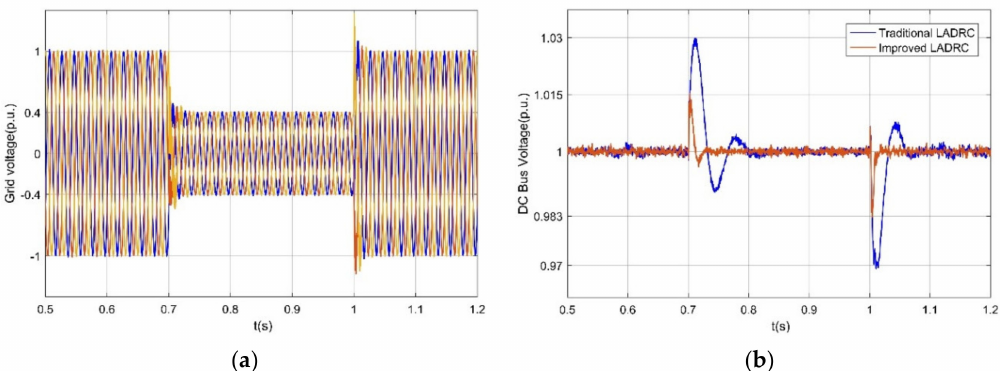
Figure 15. Power network voltage waveform and DC link voltage waveform when the power network voltage drops by 0.6 p.u. symmetrically: ( a ) Waveform of the power network voltage; ( b ) Waveform of the DC link voltage.